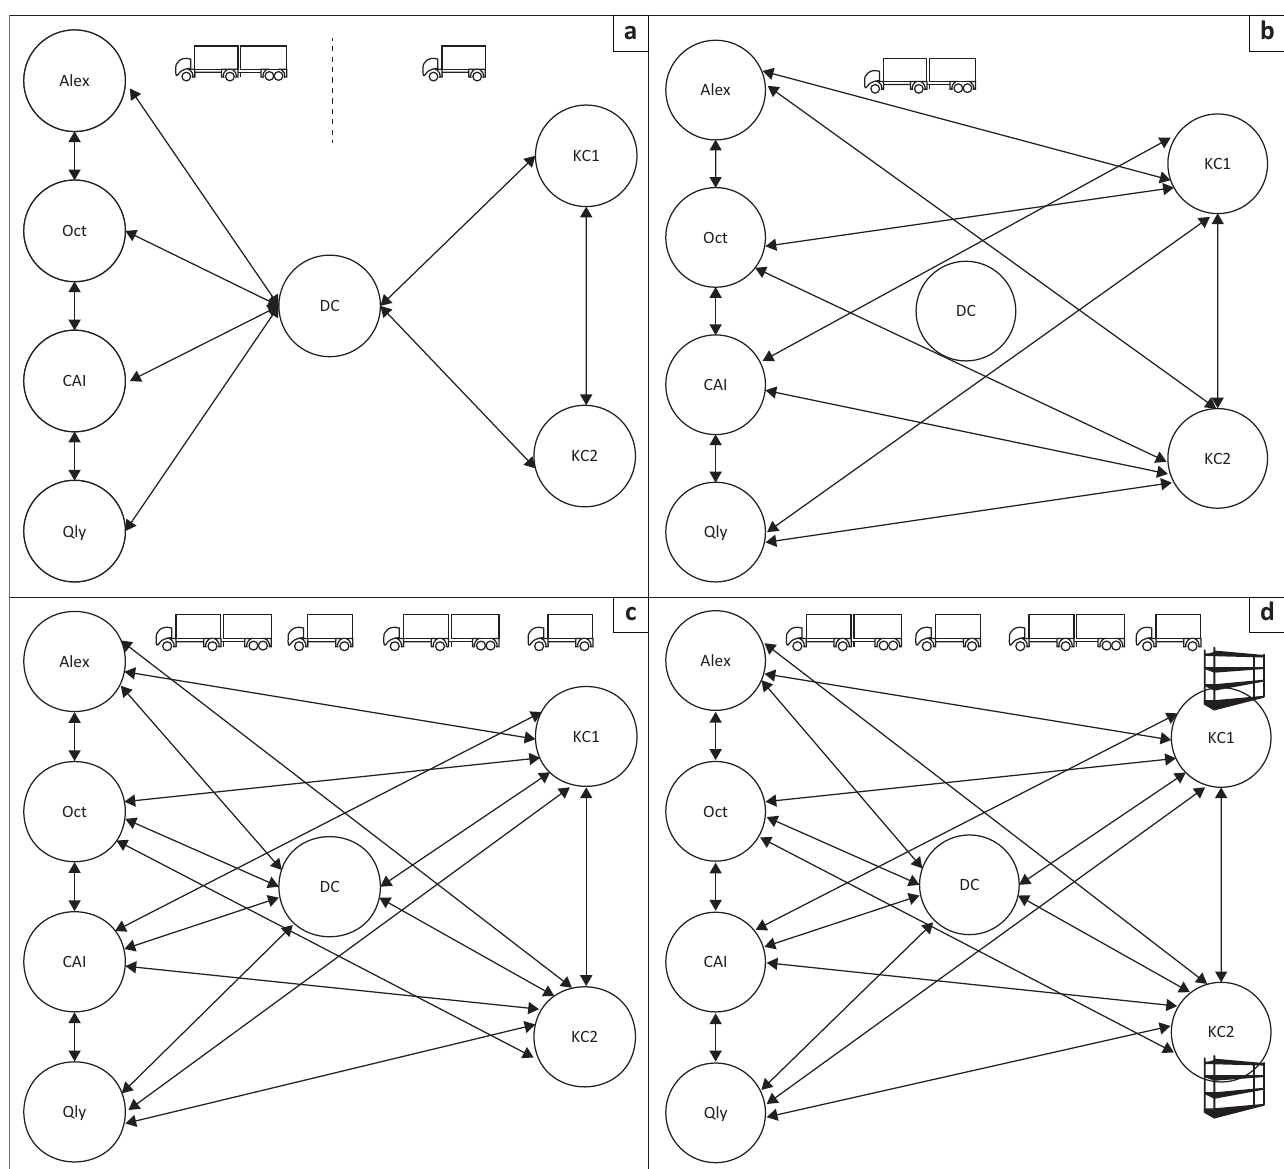
FIGURE 3: The four distribution policies of the considered distribution network designs. TABLE 4: The total cost resulted from the mixed integer quadratic problem for different planning periods. Planning period